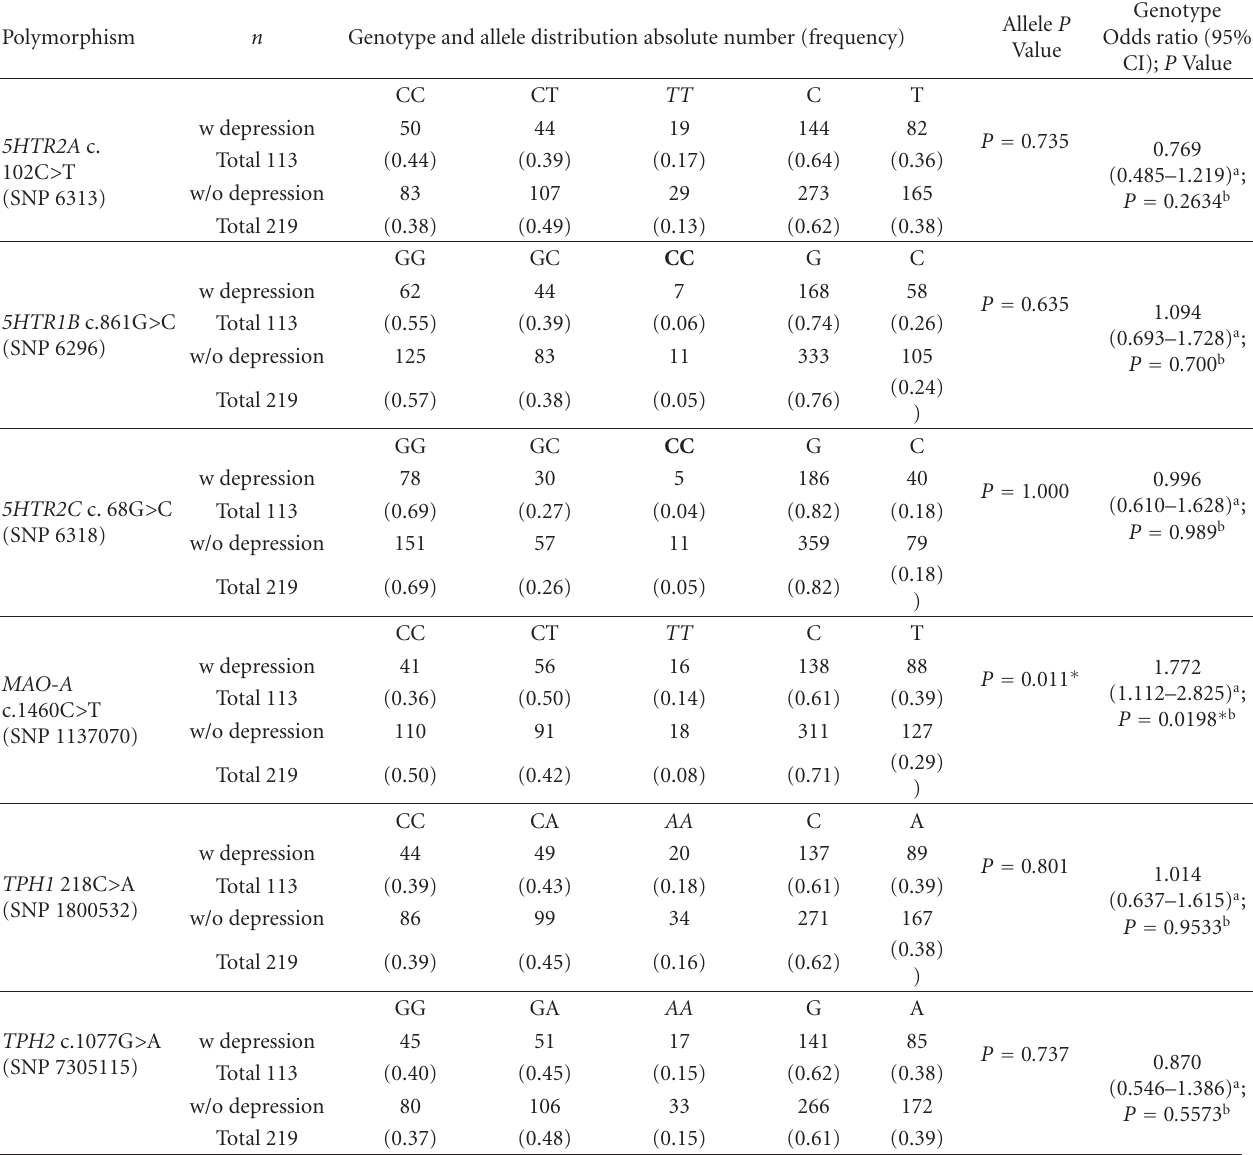
Table 1: The genotype distribution between postmenopausal women with ( w ) and without ( w/o ) depression.